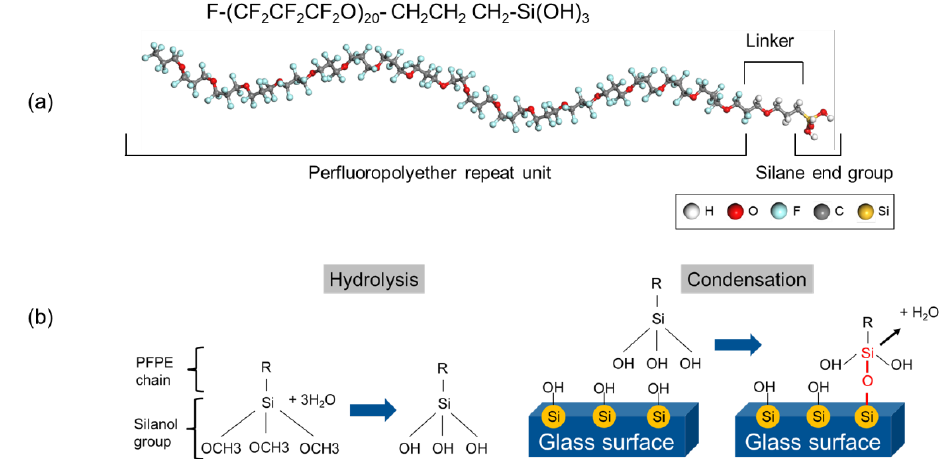
Figure 10. ( a ) Molecular structure of silane functionalized perfluoropolyether (SPFPE) single chain. ( b ) Schematics of surface reactions between silica surface and SPFPE (adapted with permission from Reference [30], Copyright 2019 American Chemical Society).